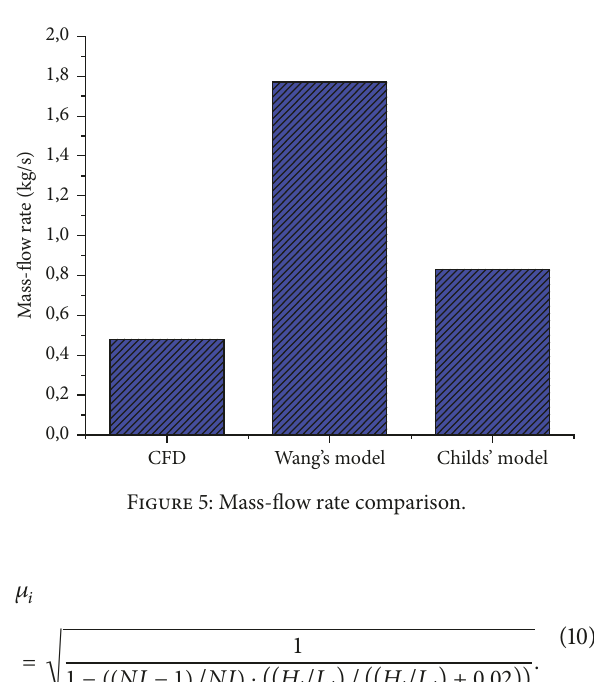
Figure 5: Mass-flow rate comparison.